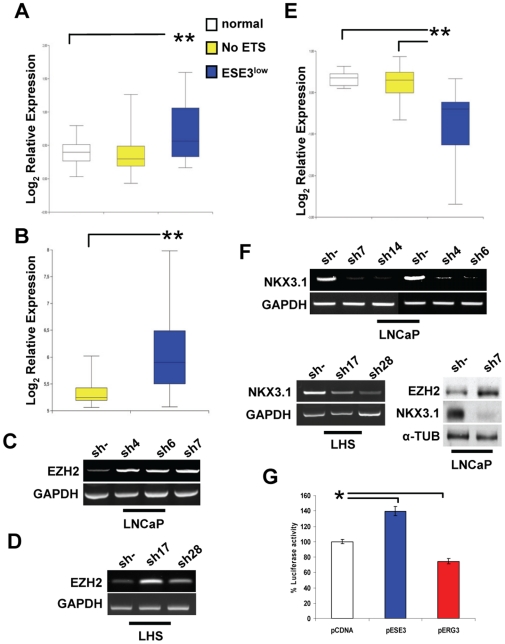
ESE-3 regulates EZH2 and Nkx3.1 expression.
A. EZH2 level in normal prostate, ESE3low and NoETS tumors. B. EZH2 level in NoETS and ESE3low tumors in Wallace et al. microarray dataset. C. EZH2 level in control (sh-) and stable ESE3 knock-down (sh 4, 6, 7) LNCaP clones determined by RT-PCR. D. EZH2 level in control (sh-) and ESE3 knock-down (sh17, 28) LHS clones determined by RT-PCR. E. Nkx3.1 level in normal prostate, ESE3low and NoETS tumors. F. Nkx3.1 level in control (sh-) and ESE3-knock-down LNCaP and LHS cells determined by RT-PCR and Western blot (right bottom). G. Nkx3.1 promoter activity in PC3 cells transfected with human NKx3.1 promoter reporter along with the indicated expression vectors. Luciferase reporter activity was measured after 24 h. *p<0.01; **, p<0.001.